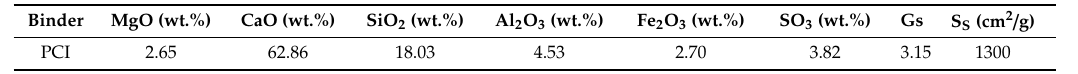
Table 3. Primary chemical and physical properties of the PCI